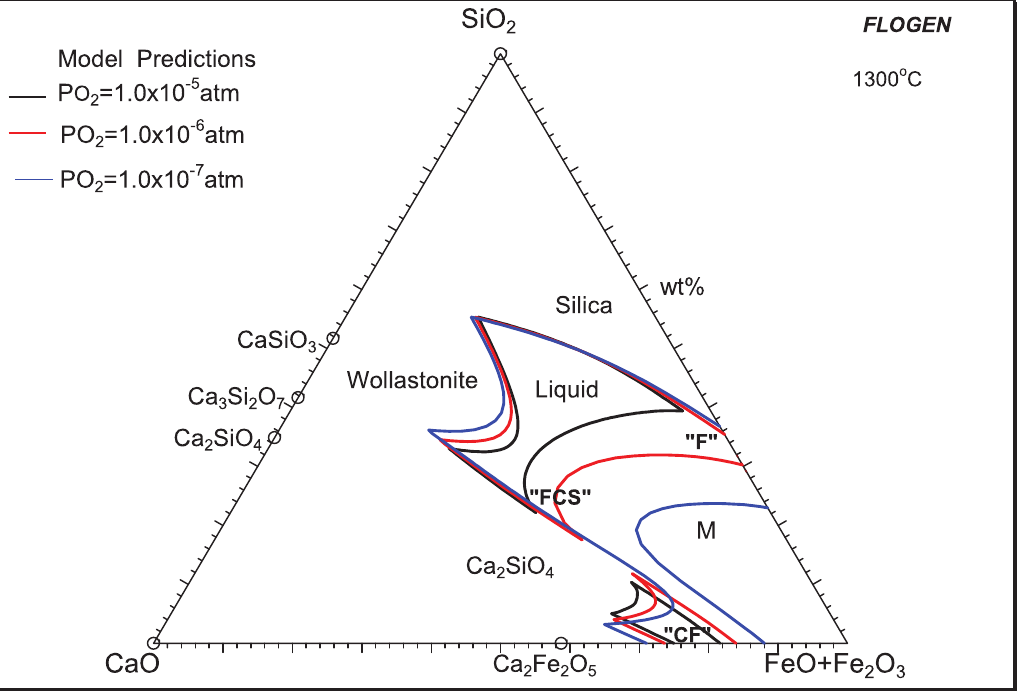
Figure 2. Effect of oxygen potential on the liquid regions of “fayalite” (“F”), “ferrous calcium silicate” (“FCS”) and cal- cium ferrite (“CF”).